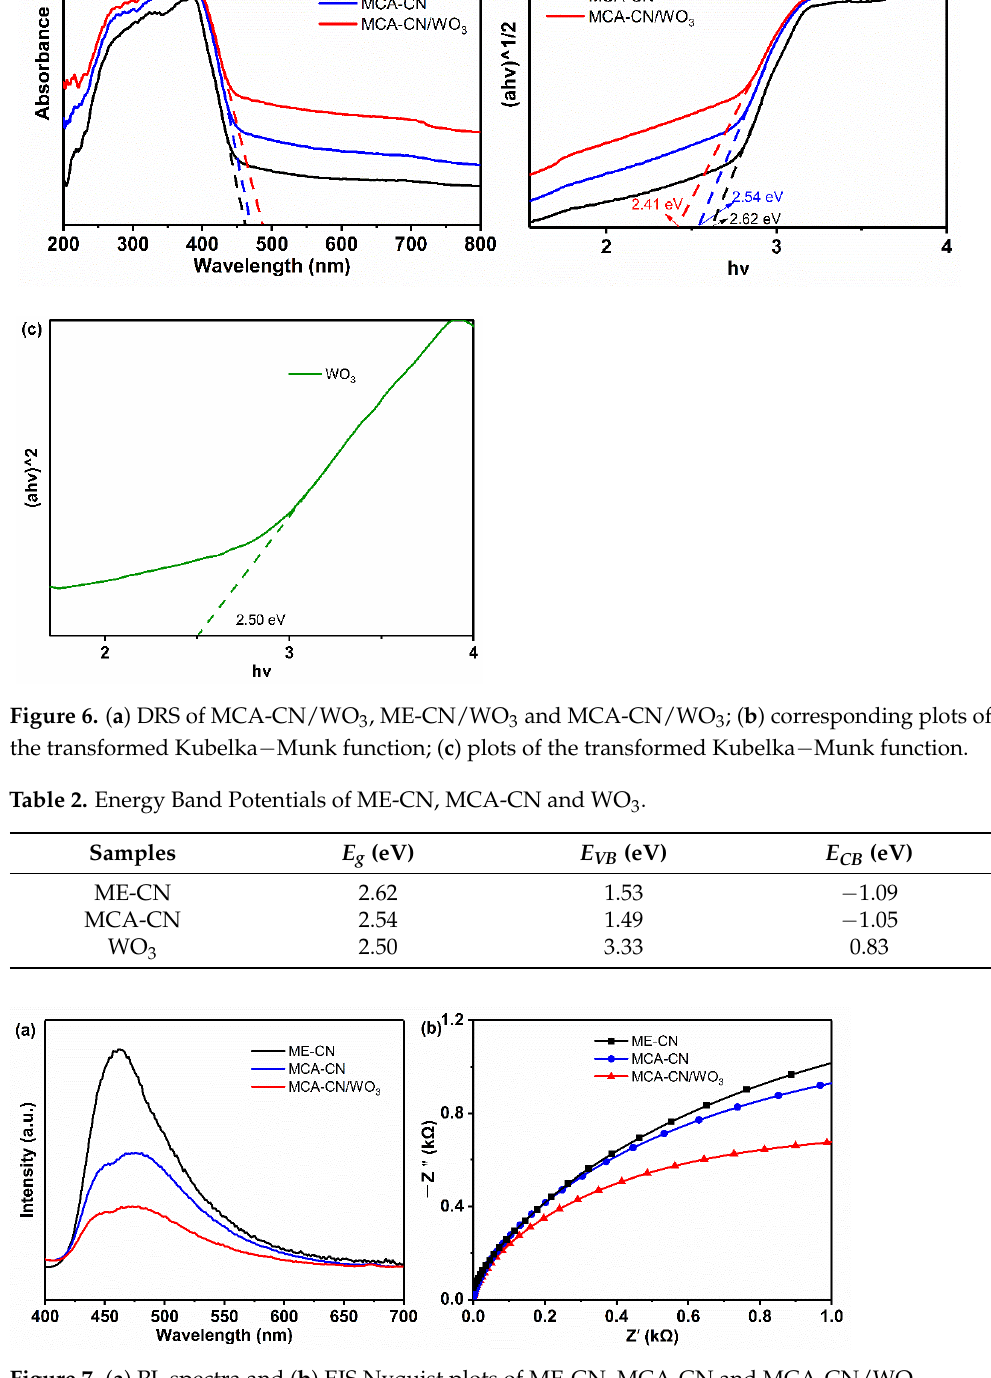
Figure 7. ( a ) PL spectra and ( b ) EIS Nyquist plots of ME-CN, MCA-CN and MCA-CN/WO 3